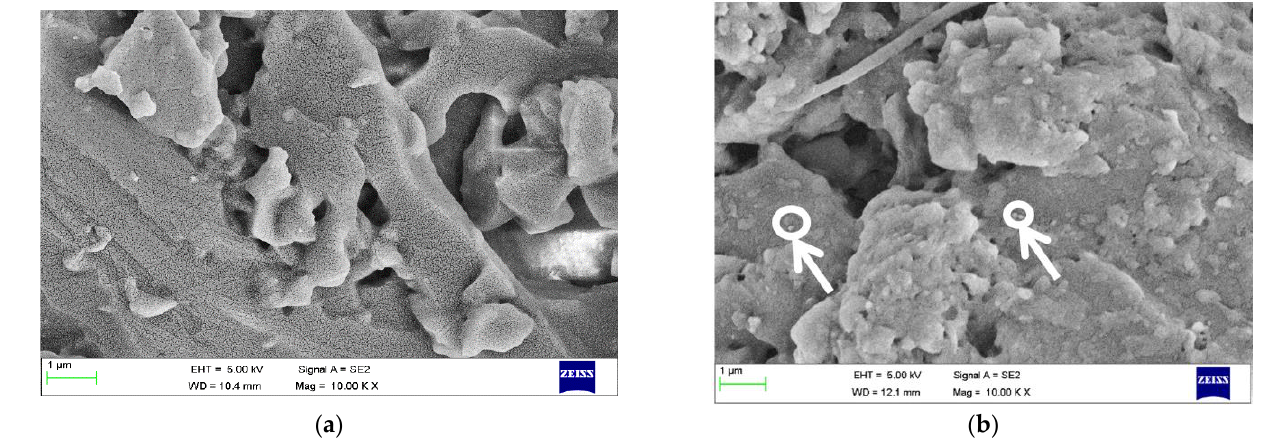
Figure 8. Patterns of nanocomposites with different reinforcement ( a ) 0.1 wt % ( b ) 0.2 wt % of GNP.